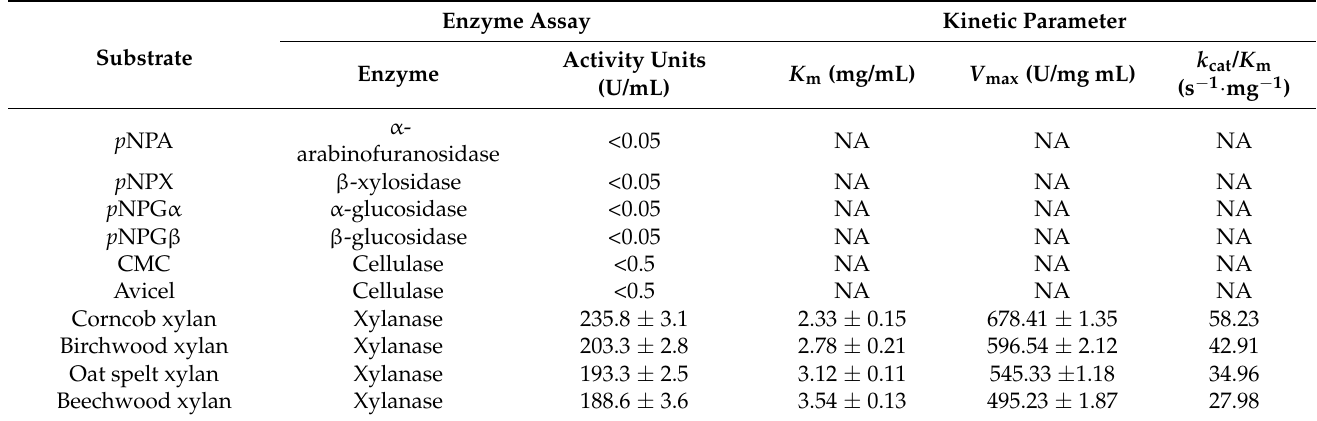
Table 2. Substrate specificity and kinetic properties of